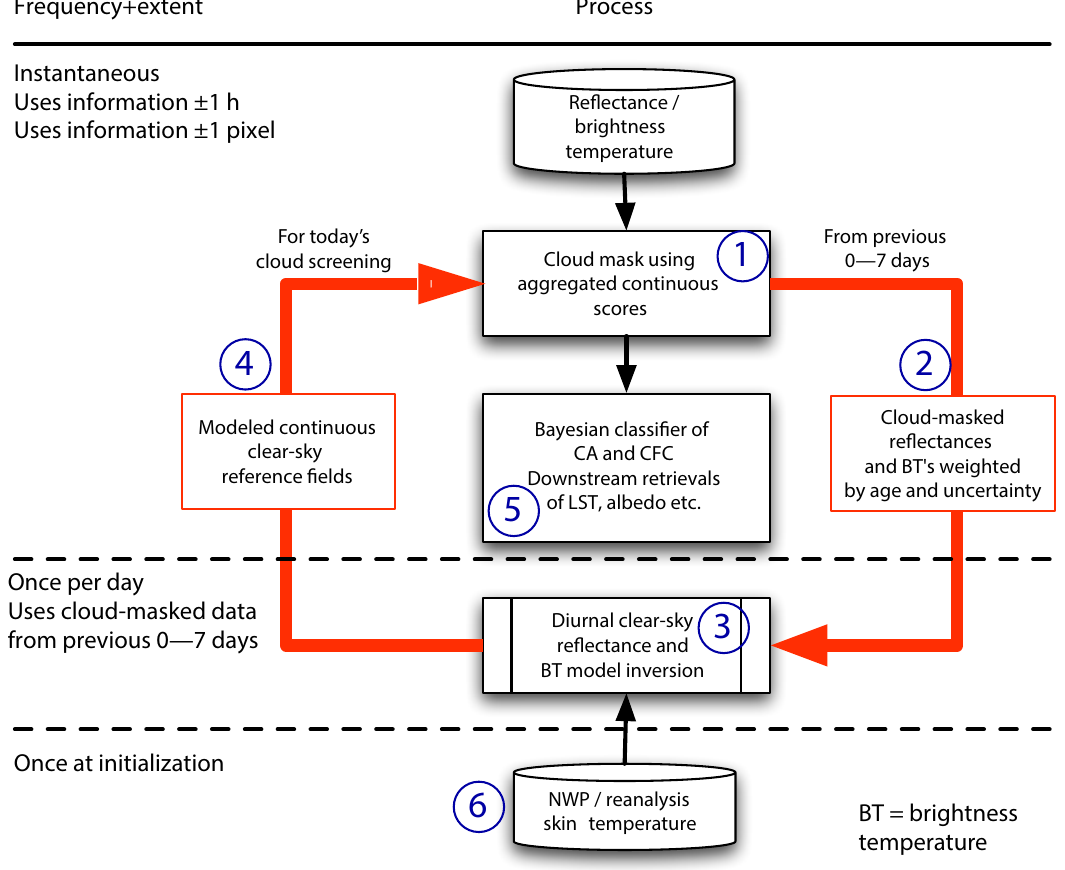
Figure 3. Flowchart showing the cyclic retrieval of clear reference fields for cloud masking subsequent data and the application of downstream retrievals using either clear or cloudy pixels. CA, Cloud Amount; CFC, Cloud Fractional